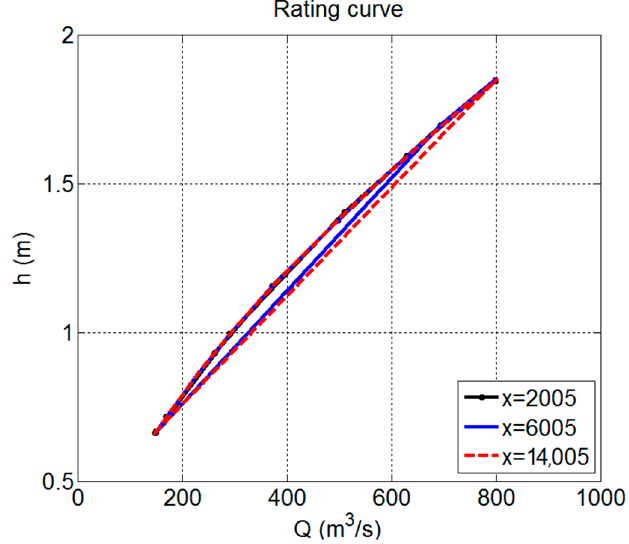
Figure 13. Wave translation: channel rating curve.